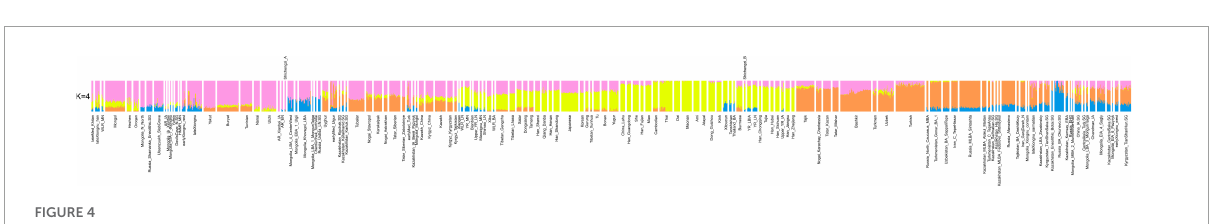
FIGURE4 The result of ADMIXTURE analysis ( K = 4) among Eurasian groups shows that two Shichengzi groups harbor disparate ancestral composition patterns. Populations mainly from southern China and Southeast Asia (yellow), Mongolia (light magenta), and West Eurasia (Orange and